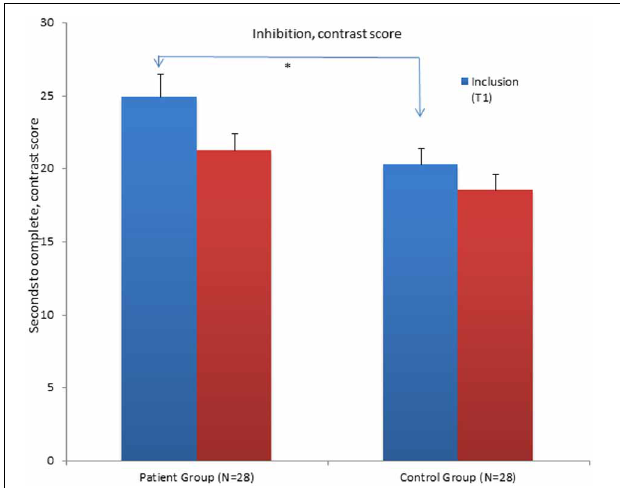
FIGURE 3 | Mean scores for the category Fluency (semantic fluency) condition of the Verbal Fluency Test (VFT) for the patient group and control group at inclusion (T1) and at follow-up assessment (T2). ∗ Significant differences between the groups. Graphs represent mean Standard Error